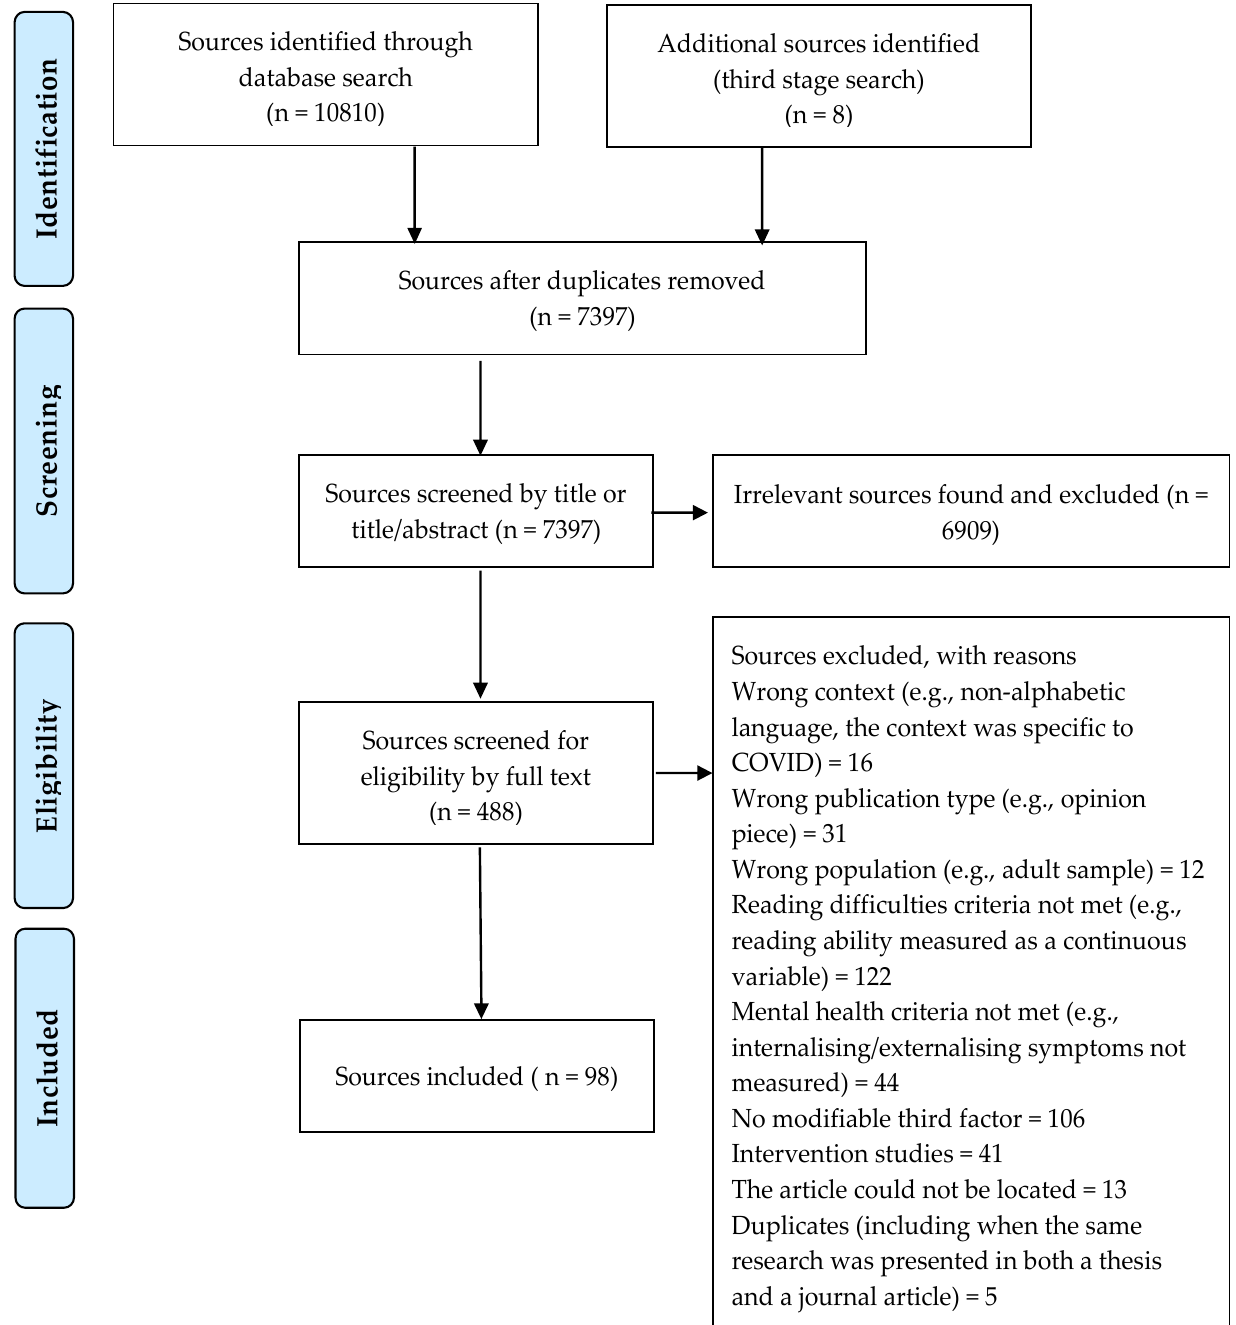
Figure 1. PRISMA flow diagram http://prisma-statement.org/ (accessed on 28 January 2021) and adapted for this scoping review.